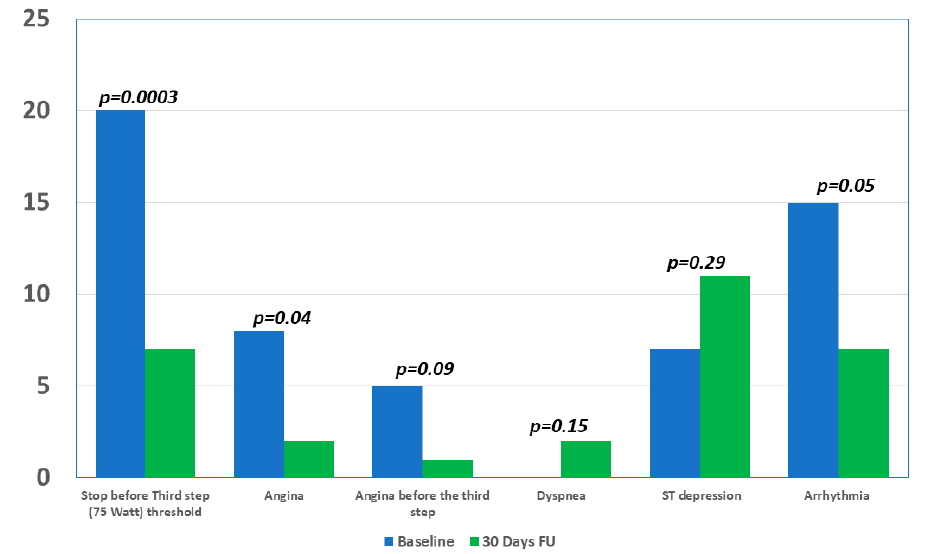
Figure 3. Graphical representation of results at baseline and at follow-up, showing a lesser rate of angina symptoms, arrhythmia, and an increase workload in terms of watts.